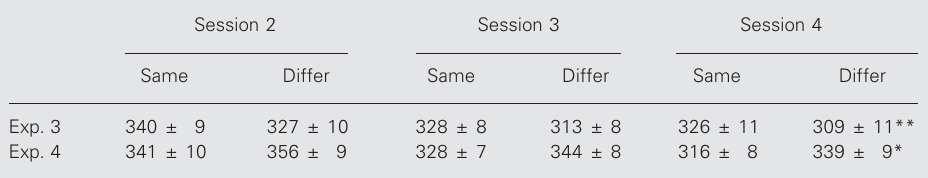
Table 2. Reaction time in milliseconds for each experimental condition of Experiments 3 (simple task) and 4 (go/no-go